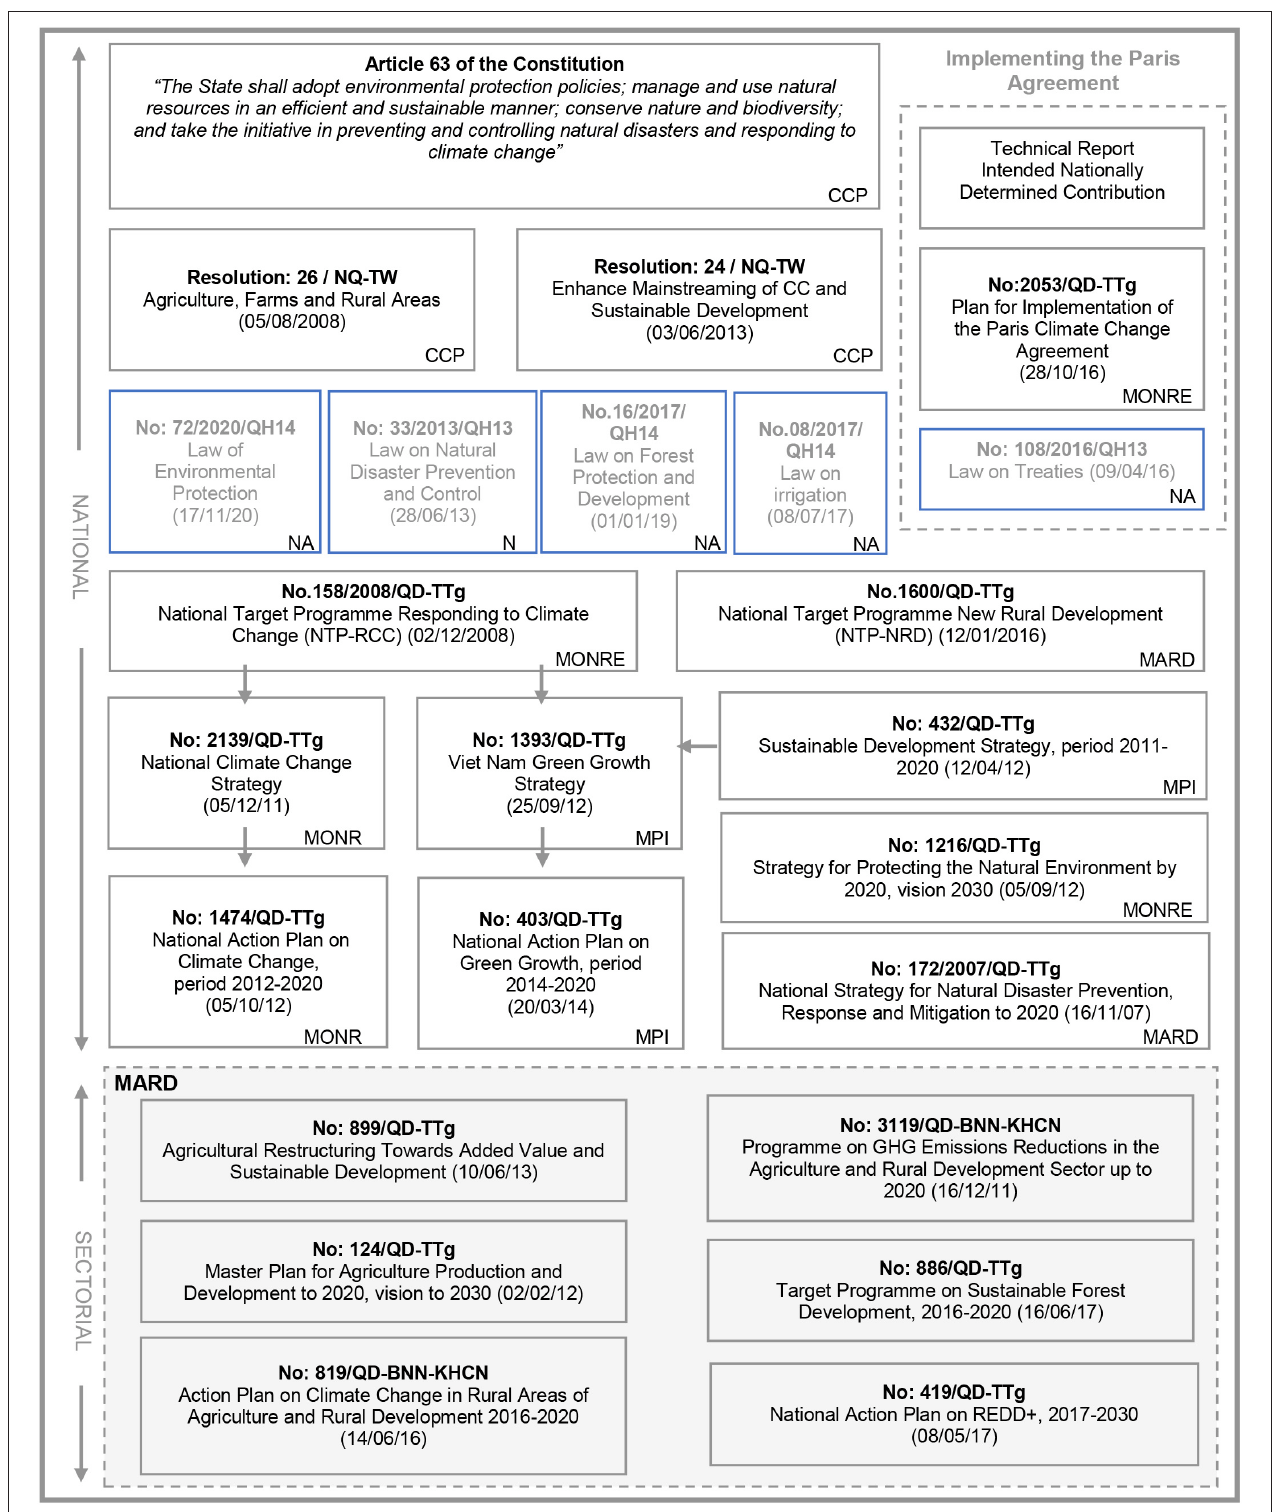
FIGURE 2 | Viet Nam’s policies, laws, and programs that focus on climate change and the agricultural sector arranged hierarchically. Articles and resolutions from the Central Committee of Party (CCP) are at the top with sub-sector specific policies from Ministry of Agriculture and Rural Development (MARD) at the bottom. Arrows show relationships between different policies. Policy typology code; NQ-Party resolution, QD-Decision, QH-Law: Signing authority; TTg-Prime Minister, BNN-MARD Minister, KHCN-MOST Minister: lead ministry, bottom right-hand corner.